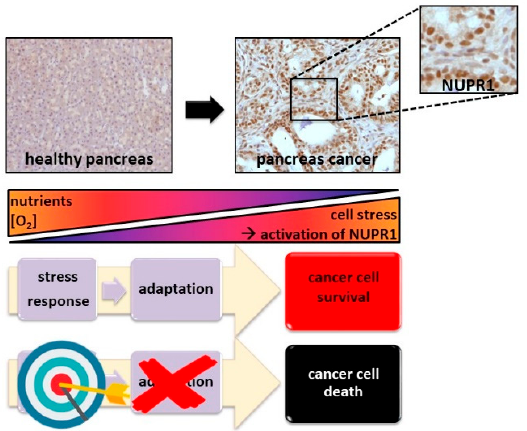
Figure 1. Targeting the stress response protein NUPR1 is a promising therapy for treating cancer. Pancreatic cancer cells are extremely challenged by a stressful environment due to a poor concentration of nutrient and oxygen, among other factors. In order to adapt themselves and survive, tumor cells activate stress response pathways overexpressing stress proteins such as NUPR1, which is constantly present in the tumor tissue. Our strategy is focused on targeting NUPR1 to induce cancer cell death as a therapeutic treatment for cancer.